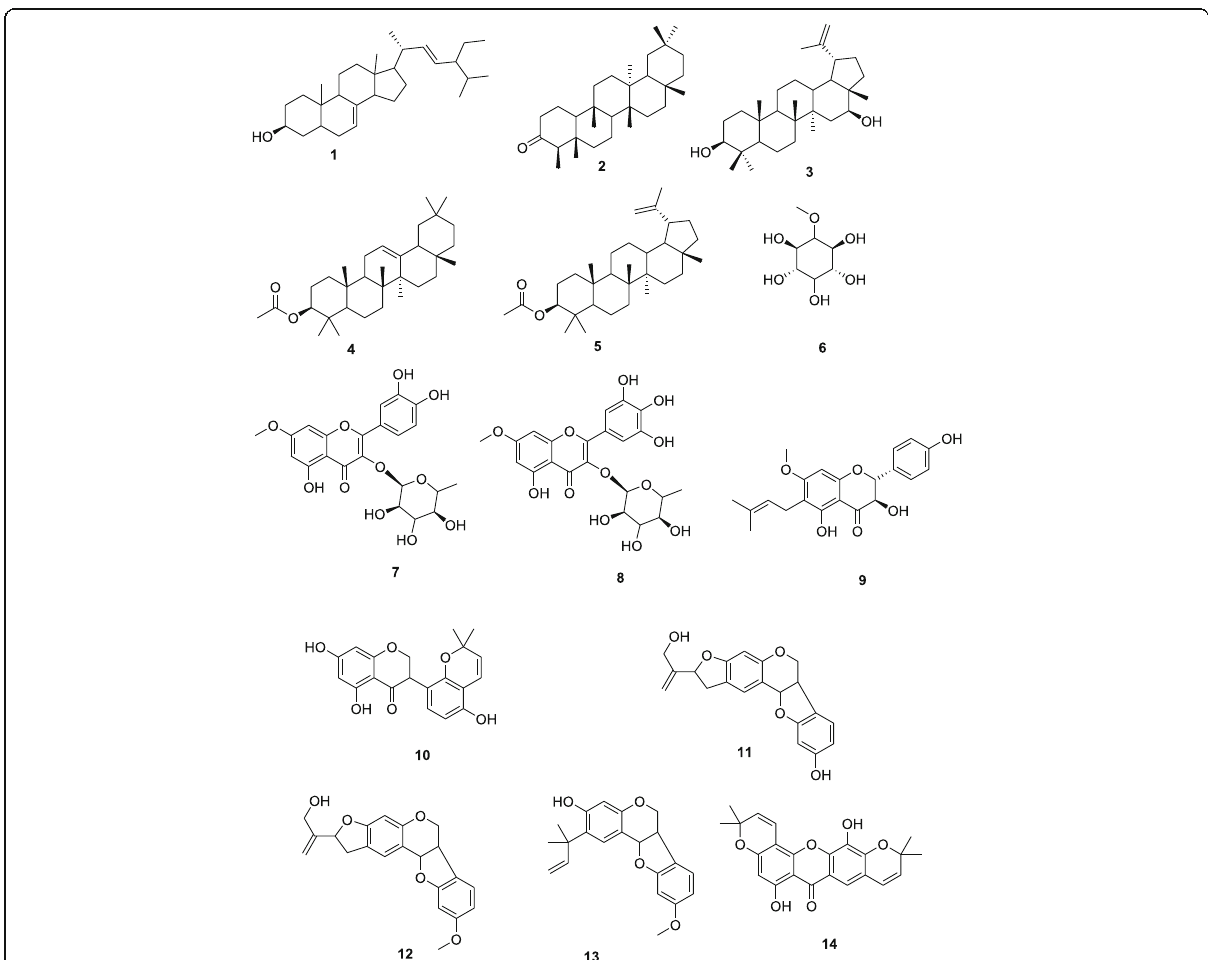
Fig. 1 Chemical structures of tested compounds. 1: β -spinasterol; 2: friedelanone; 3: 16 β -hydroxylupeol; 4: β -amyrin acetate; 5: 5- O -methyl-myo-inositol or sequoyitol; 6: lupeol acetate; 7: rhamnitrin or 7- O -methylquercetin 3- O -rhamnoside; 8: europetin 3- O -rhamnoside or 7- O -methylmyricetin 3- O -rhamnoside; 9: thonningiol; 10: glyasperin F; 11: seputhecarpan B; 12: seputhecarpan C; 13: seputhecarpan D; 14: rheediaxanthone